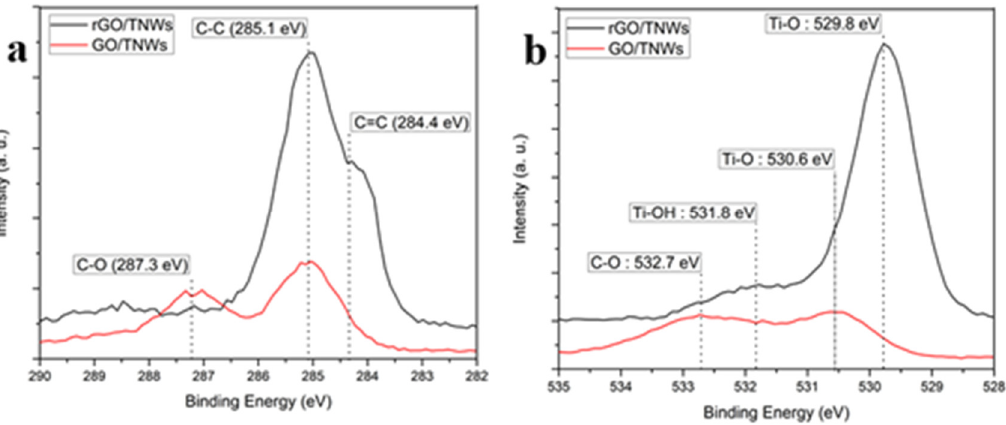
Figure 5. ( a ) Typical high-resolution XPS spectra of C 1s and ( b ) O 1s XPS spectra of rGO/TNW and GO/TNW samples.